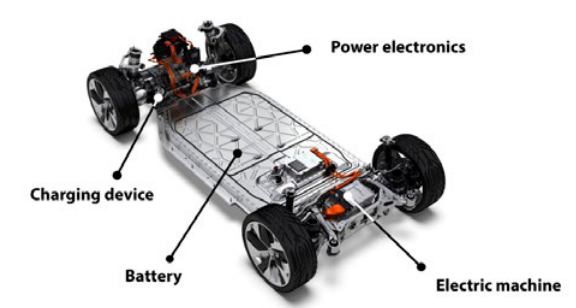
Figure 3. The key components of a battery electric vehicle (BEV).